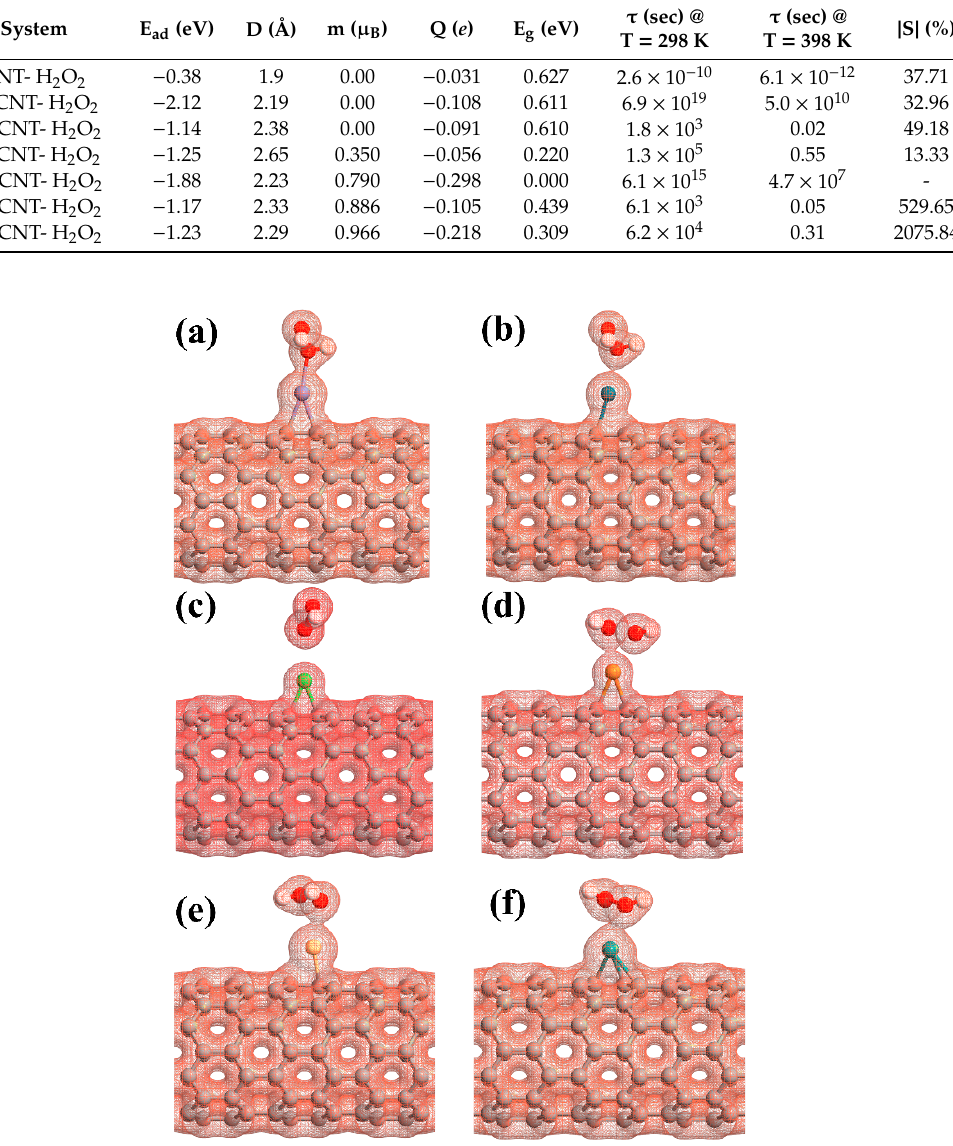
Figure 8. The electronic total charge densities for the adsorption of H 2 O 2 on ( a ) Pt ‐ SWCNT, ( b ) Pd ‐ SWCNT, ( c ) Ni ‐ SWCNT, ( d ) Cu ‐ SWCNT, ( e ) Rh ‐ SWCNT, and ( f ) Ru ‐ SWCNT systems. The sticks between atoms are only for visualization.